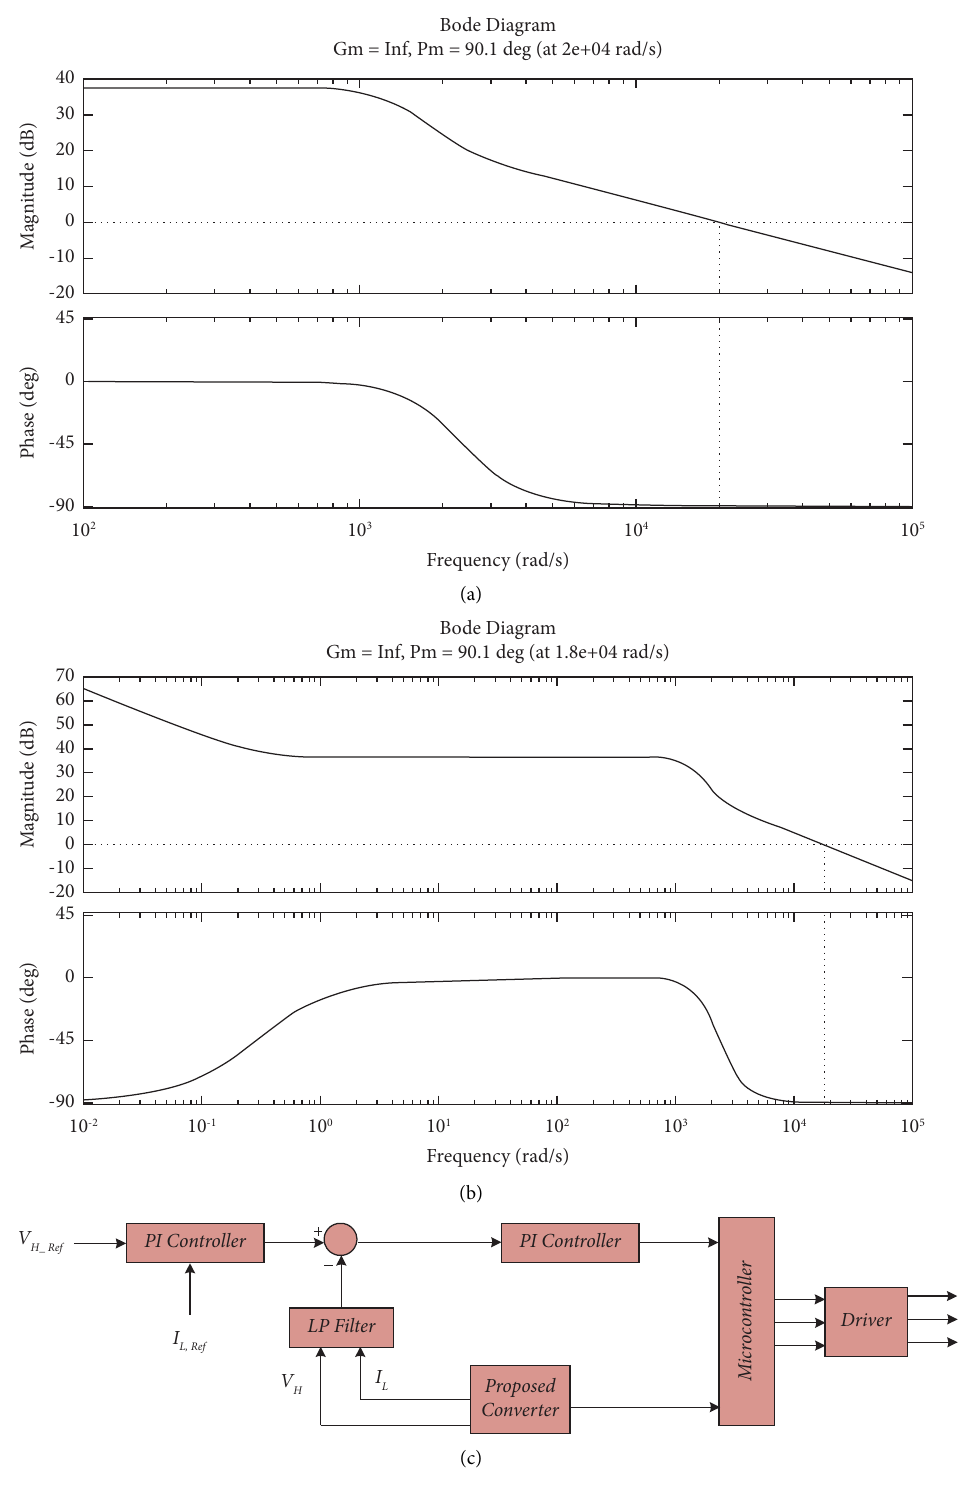
Figure 8: Bode plod and controller scheme of the suggested converter: (a) frequency response in boost mode, (b) frequency response in buck mode, and (c) control loop of the suggested